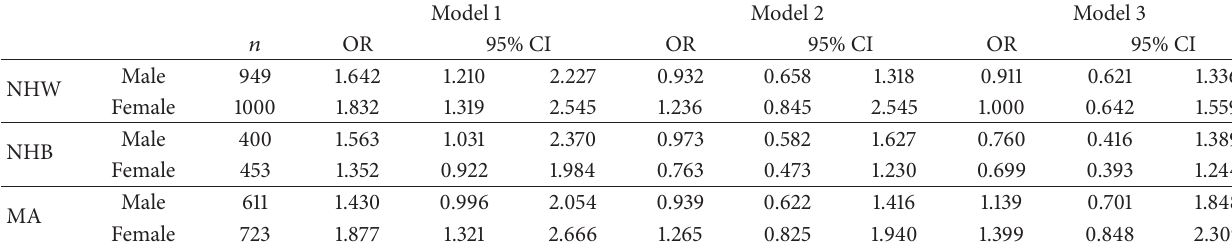
Table 3: Odds ratios for abnormal glucose tolerance based on H. pylori